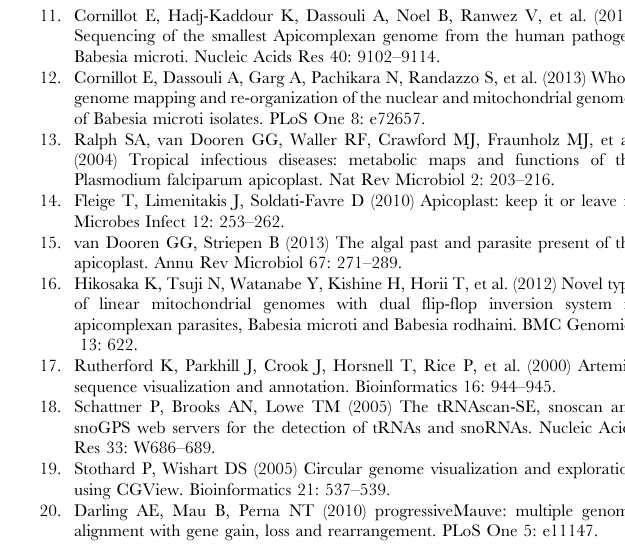
figure was generated using Pfam server either using UNIPROT accession number or by direct submission of the amino acid sequence. Regions of low complexity are represented in blue. PfamB domains are represented by horizontal lines. Table S1: Primers used to assemble and sequence the B. microti apicoplast genome. Coordinates are given according to the